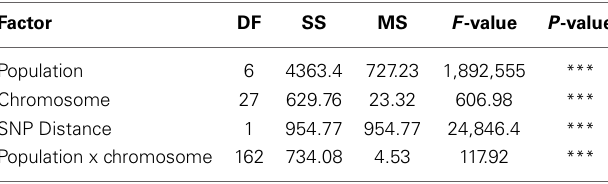
Table 3 | The effects of population, chromosome and SNP marker interval on linkage disequilibrium ( r 2